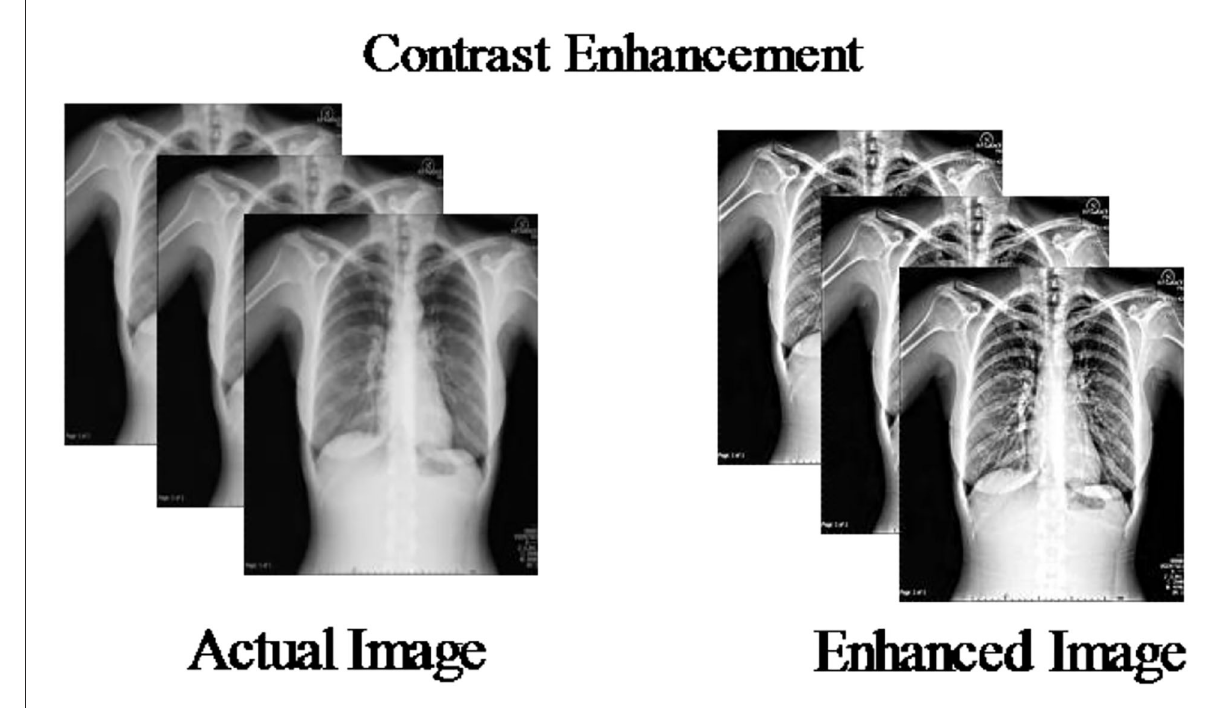
FIGURE3 Sample resultant images of hybrid contrast enhancement